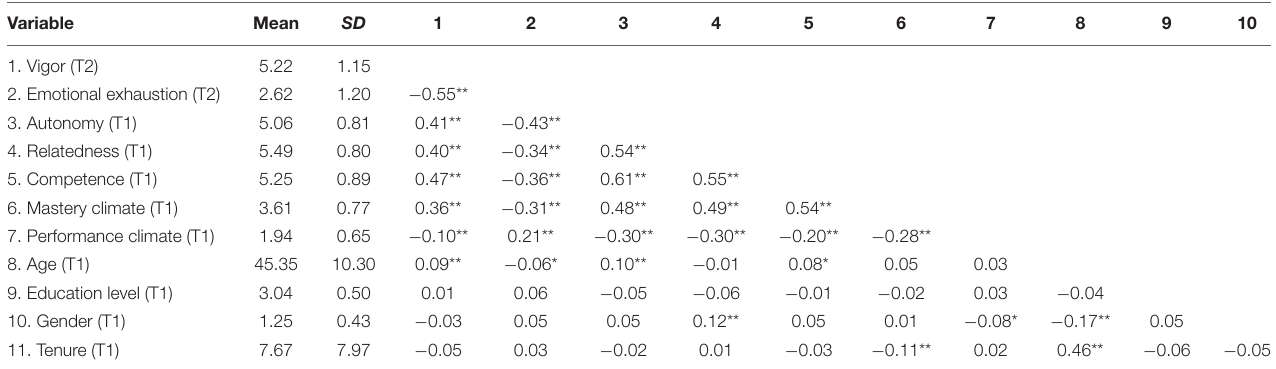
TABLE 2 | Means, standard deviations, and correlations with confidence intervals ( n = 1,081). Variable